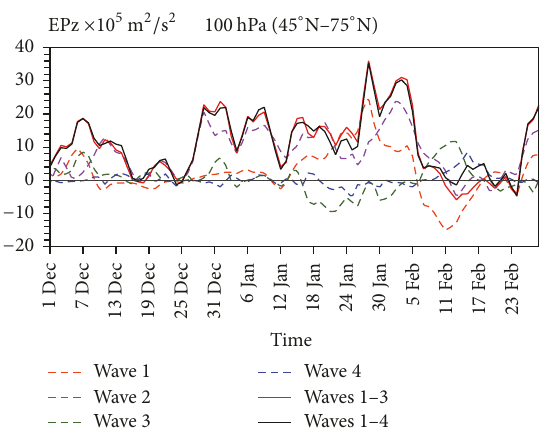
Figure4:TimeseriesoftheverticalcomponentoftheEPFforwaves 1–4 (curves; 10 5 m 2 s −2 ) over 45 ∘ –75 ∘ N at 100hPa from December 2013 to February